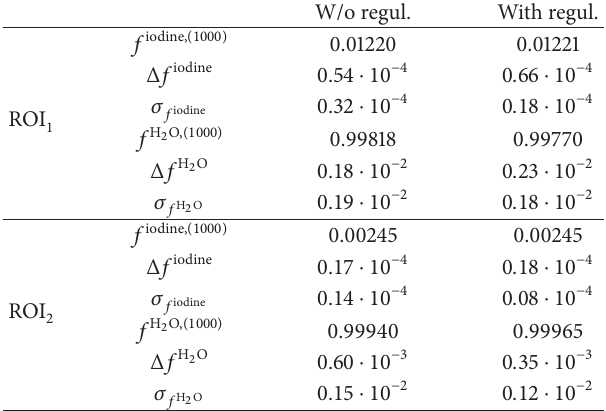
Table 1: Results of the accuracy analysis of the algorithm with and w/o regularization (regul.). The material fractions 𝑓 ∗,(1000) were measured after 1000 iterations in the respective material images within ROIs located as indicated in Figures 4(a) and 4(b). The standard deviation of the ROI data 𝜎 𝑓 ∗ measures the fluctuation induced by the forward- and back-projector. The values of Δ𝑓 ∗ quantify the offset between the ground truth 𝑓 ∗,(0) and the material fraction after 1000 iterations. W/o regul. With